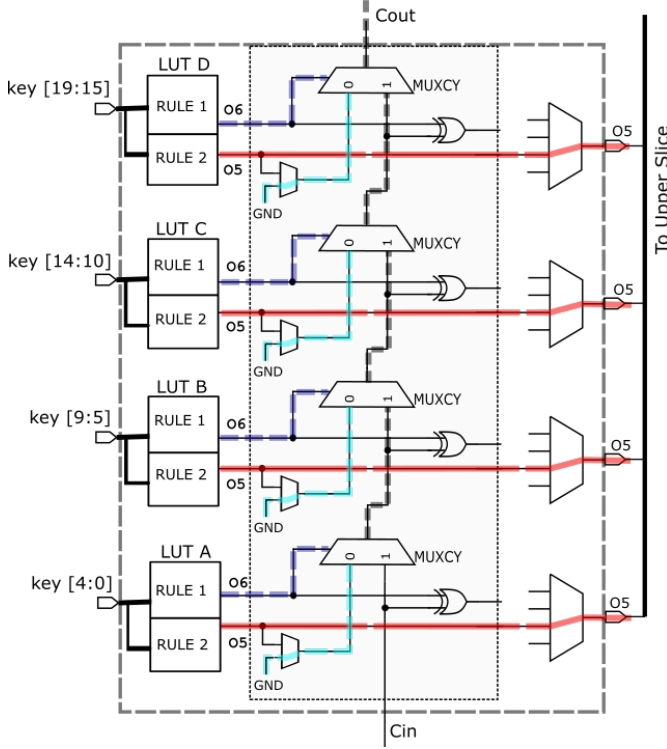
Figure 3. Mapping of a 2 × 20 TCAM to four 5 × 2 LUTs in a first